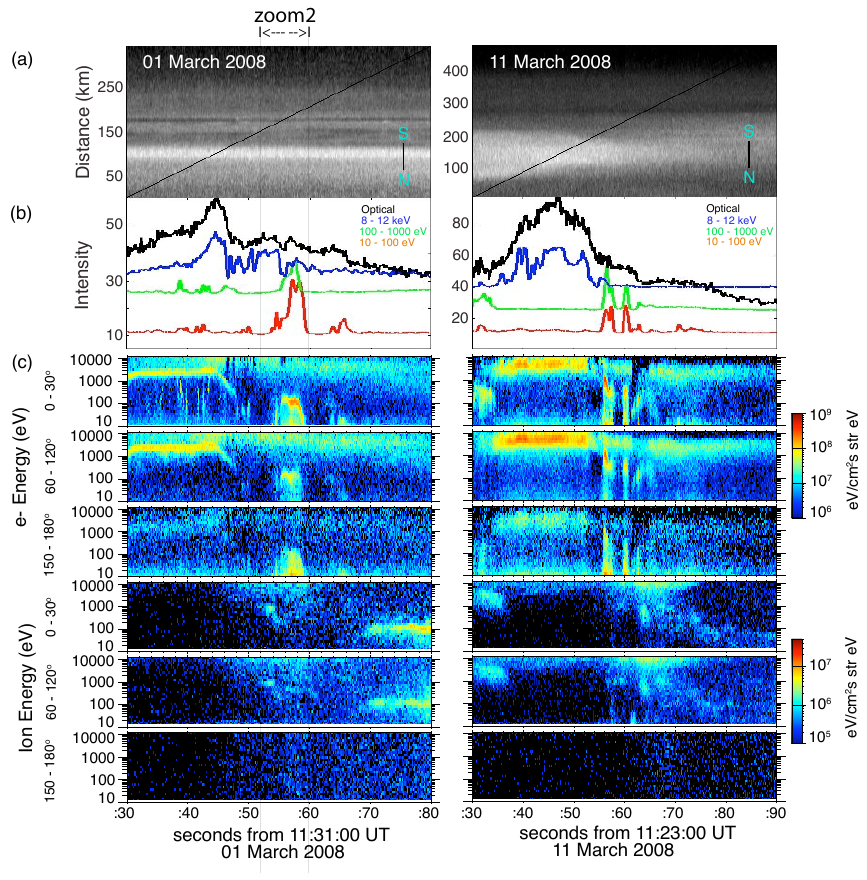
Fig. 3. Same format as Fig. 2, with 1 March 2008 in the left panel and 11 March 2008 in the right panel. Zoom2 denotes one of the specific time periods shown in Fig.